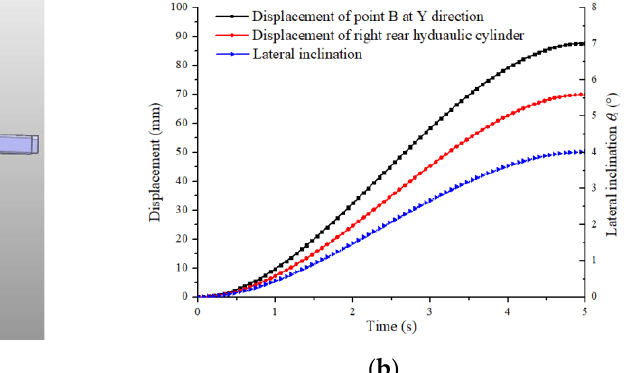
( b ) Figure 10. Simulation results of longitudinal tilting adjustment when the vehicle is in the lowest: ( a ) Displacement curve of the hinge point in the Y-direction. ( b ) Hydraulic cylinder displacement and lateral inclination θ 2 . During the first 5 s, the rear hydraulic cylinders on both sides shrink by 30 mm at the same time, and point B is always higher than point M , indicating that the frame is tilted